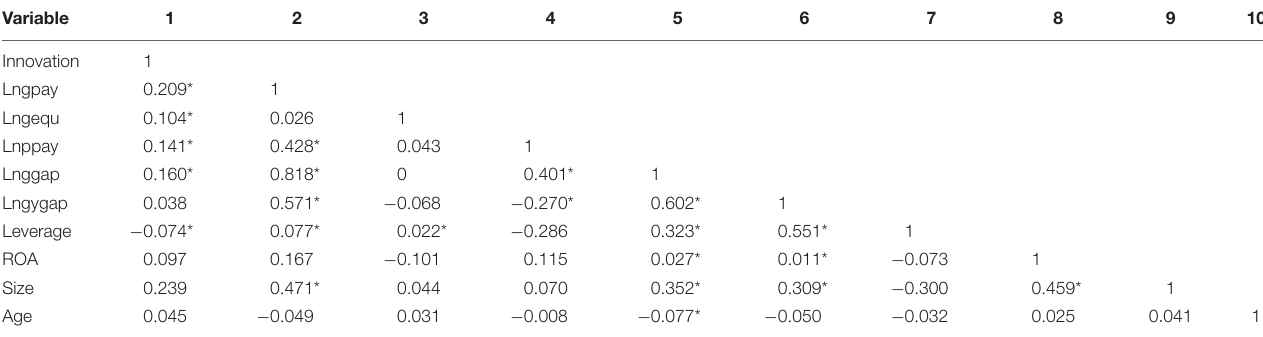
*Indicates a significant positive correlation at a level of 1%.